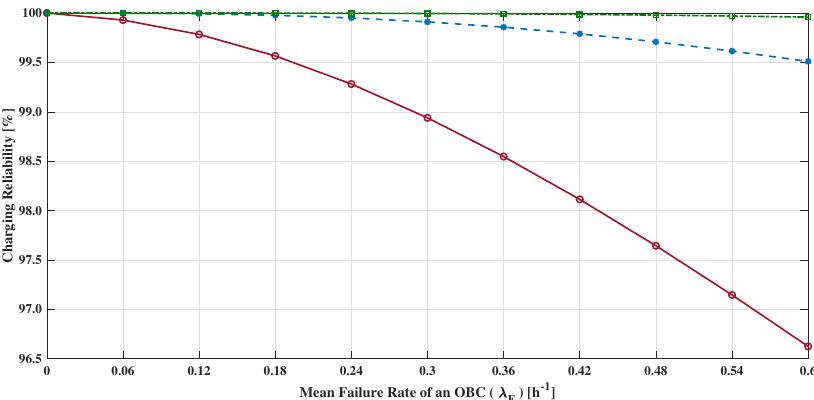
Figure 4. Reliability of charging completion of UEVs as a function of λ s .